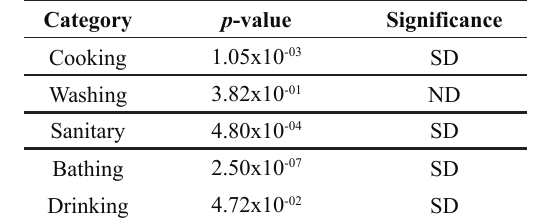
Figure 3: Histograms showing the respective counts for drinking, bathing, sanitary, washing, and cooking water usages (L/day) for Puttalam and Kalpitiya areas. Table 2: Mann-Whitney U test results for each category Category p -value Significance